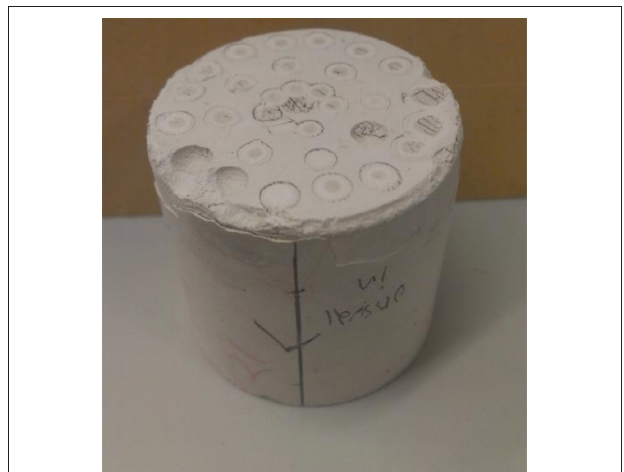
FIGURE 9 | Inlet side of the 130 ◦ C and 0.5MPa effective stress (OBSV21) core after the experiment completed. In this experiment the stresses are too low to induce compaction and grain re-organization, although the temperature is high such that dissolution/precipitation occurs at the entry-points of the injected MgCl 2